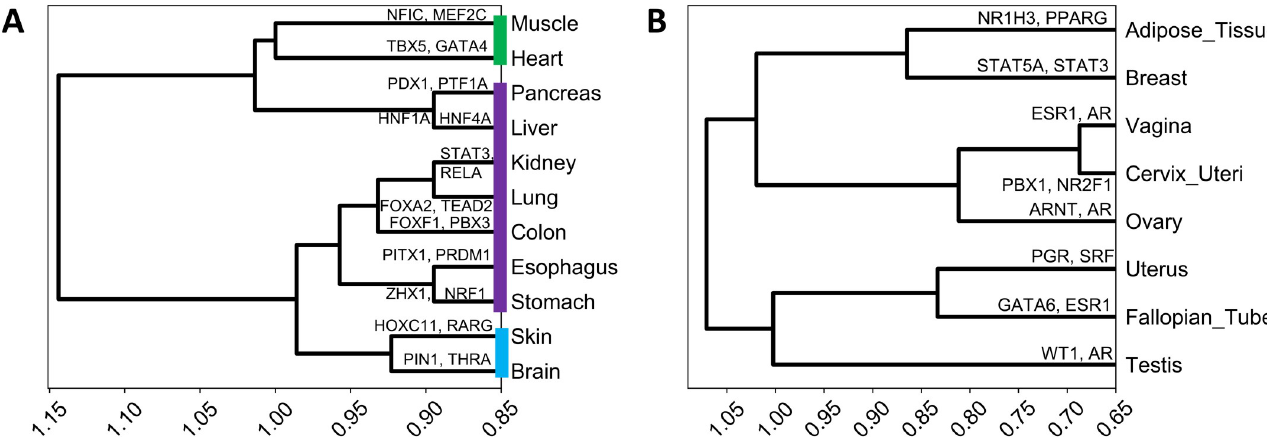
Fig 4. Top TRTFs capture developmental as well as structural relations among several mature tissues. (A) Cluster dendrogram of tissues belonging to the endodermal (purple), mesodermal (green) and the ectodermal (blue) lineages. (B) Cluster dendrogram of primary and secondary reproductive organs and adipose tissue. As an illustration, we have shown for each tissue, two top TFs previously shown to be involved in the tissue development or homeostasis.